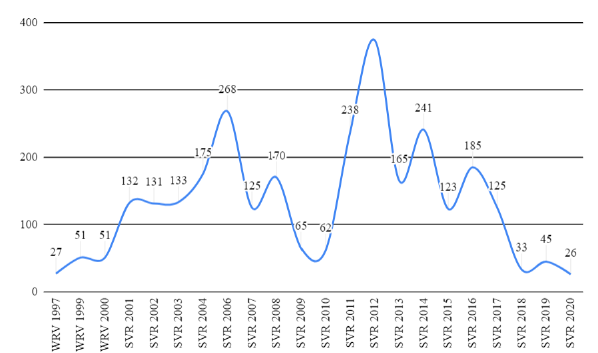
Figure 3. Overall distribution of the main application areas targeted by SVR papers. geographical distribution of Brazilian authors is shown in Figure 5, considering the five Brazilian macro regions: North, Northeast, Midwest, Southeast and